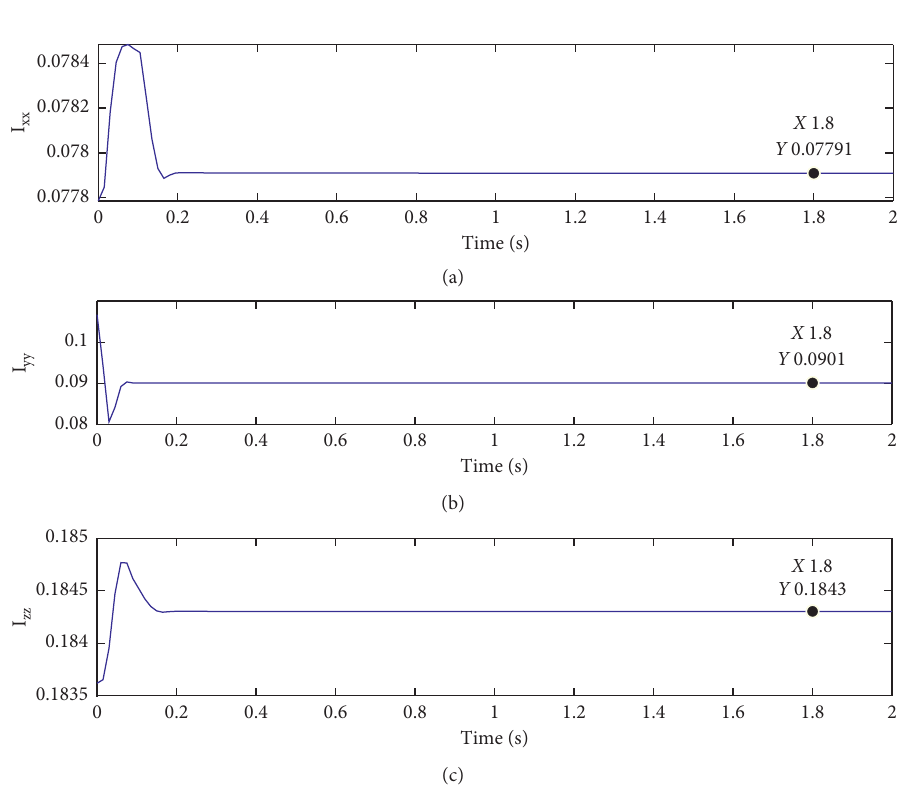
Figure 16: The estimated value of mass.